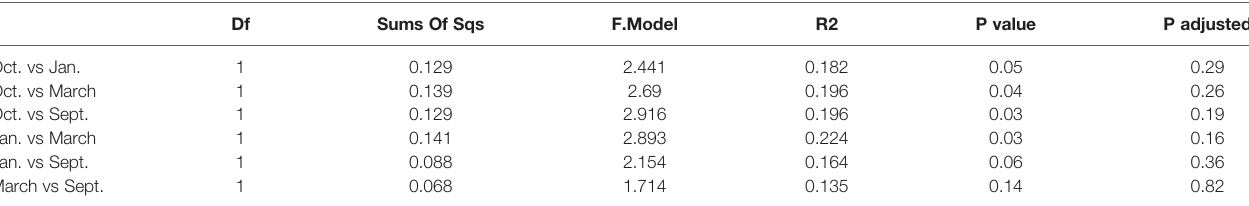
TABLE 2 | Pairwise-PERMANOVA results based on Bray-Curtis dissimilarity on Hellinger standardized densities of zooplankton community structure in relation to cruise. Df